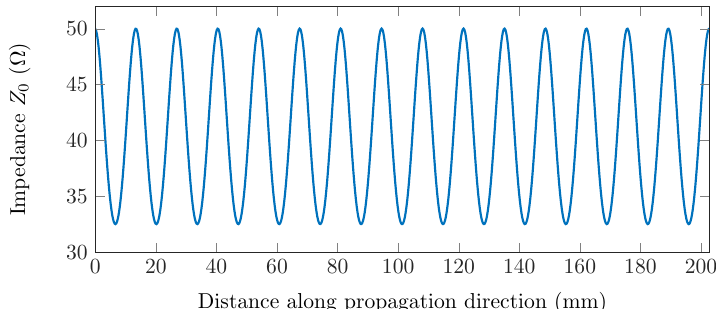
Figure 3. Variation of the impedance ( Z 0 ) along the propagation